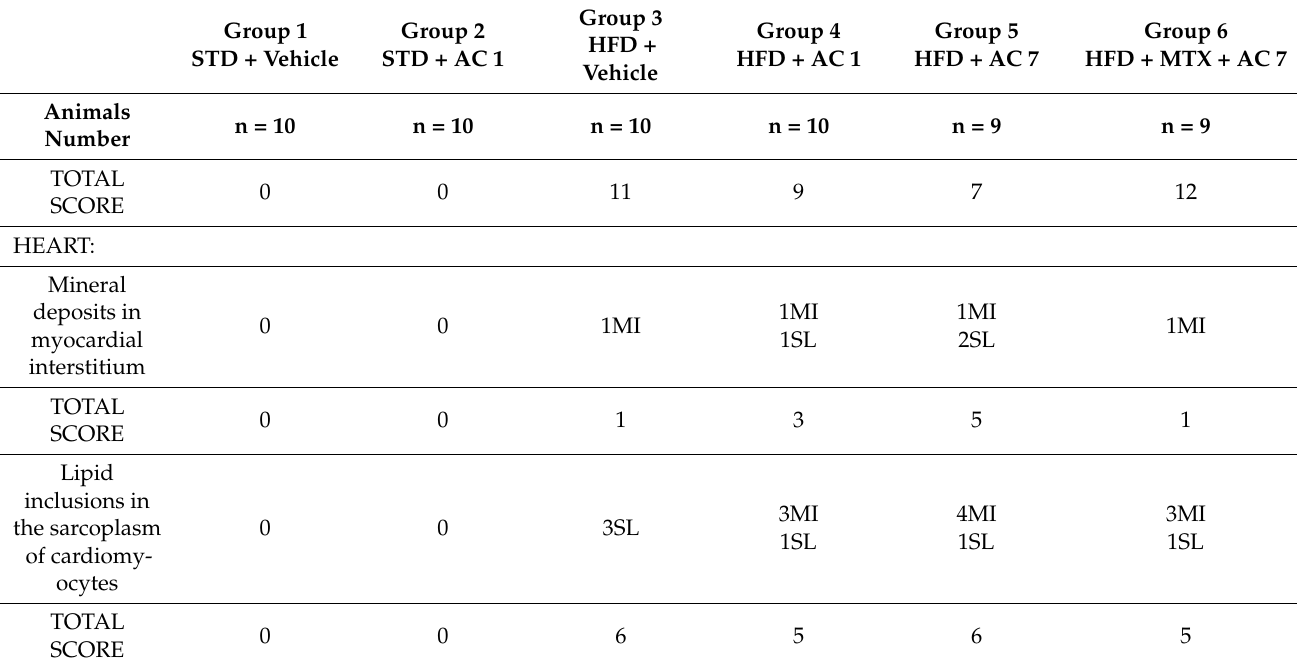
Figure 2 shows micrographs of histological preparations, which display typical pathomorphological changes that develop in animals under conditions of HFD and are characteristic for metabolic syndrome manifestation.